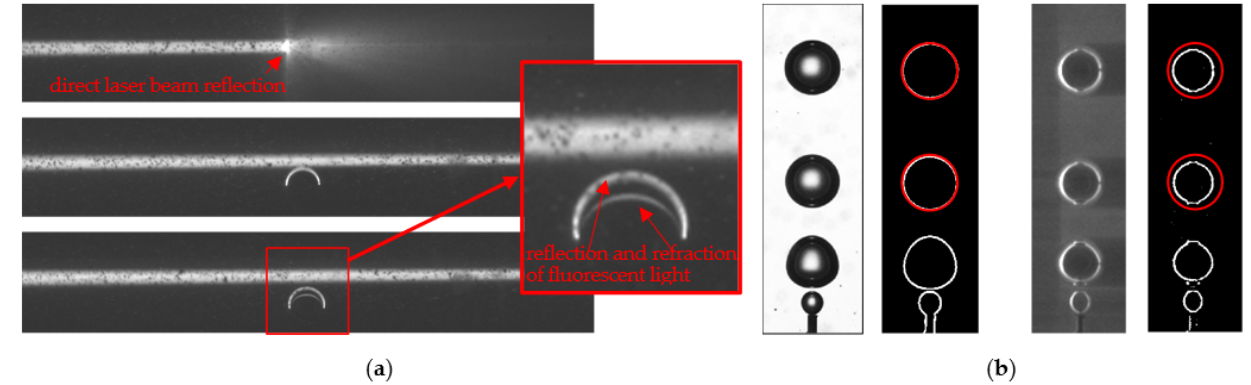
Figure 7. ( a ) PFBI image of a round bubble approaching a laser beam; ( b ) Comparison between ST and BFBI images and detected boundaries for freely rising bubbles.